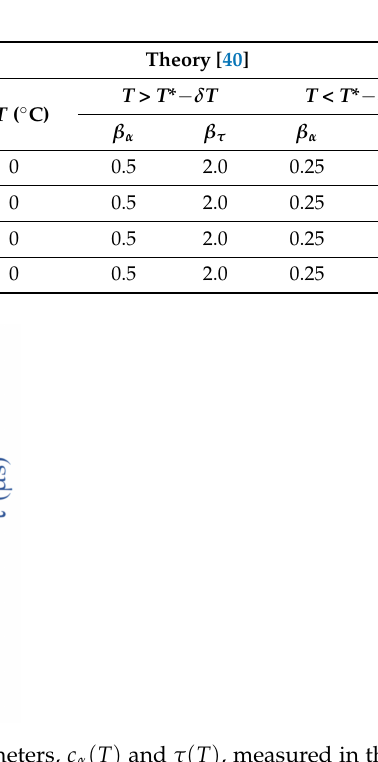
Figure 7. Temperature dependence of the ECE parameters, c α ( T ) and τ ( T ) , measured in the N TB phase of the dimer CB7CB. The inset shows a magnification of the relatively large N-N TB biphasic coexistence